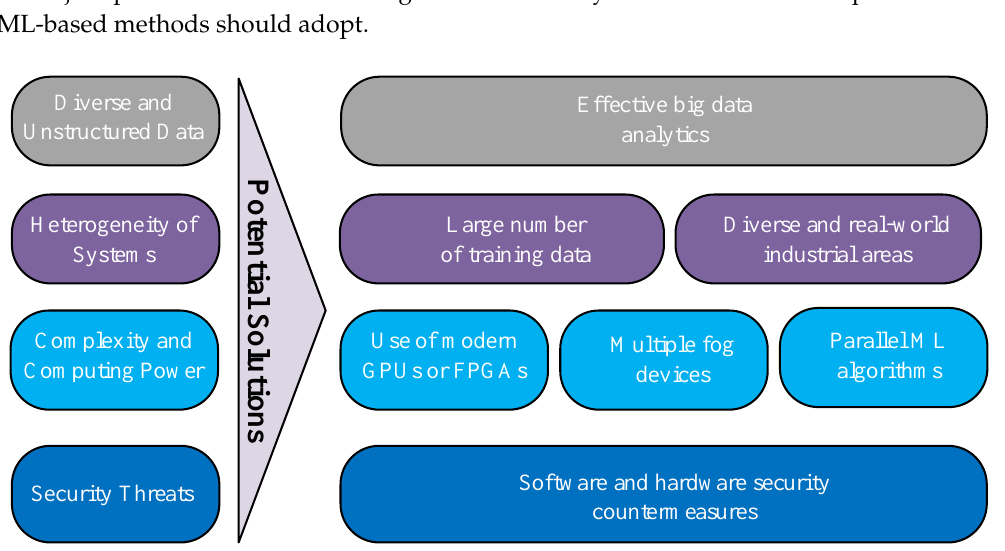
Figure 4. Open issues and potential solutions towards tackling faults in Industry 4.0 through